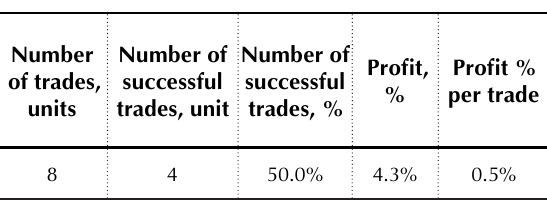
Table 4. Trading simulation results for the PFST returns over the period 1997–2018: economic